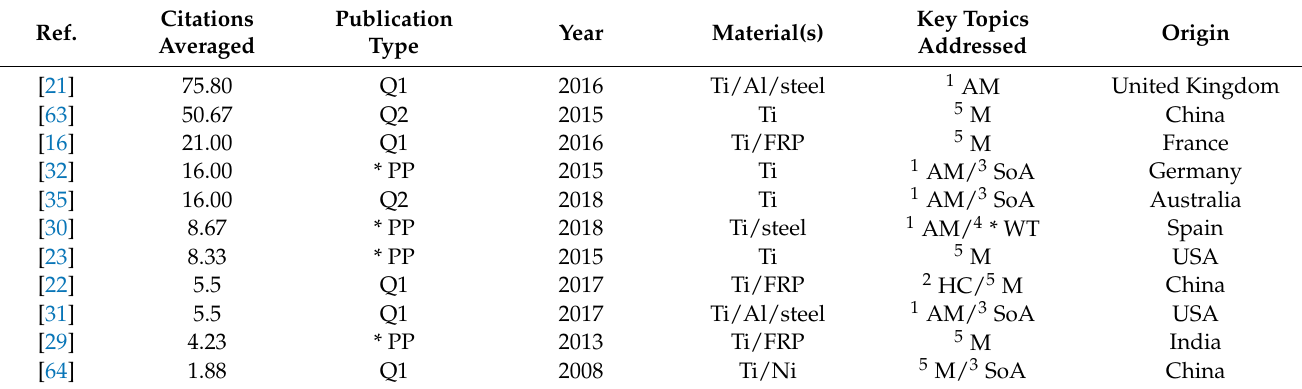
Table 5. Summary of studies including titanium alloys, listed by the average number of citations, taking into account the number of years the article has been published.